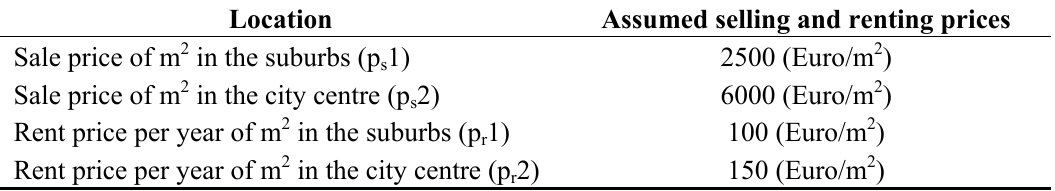
centre and in the